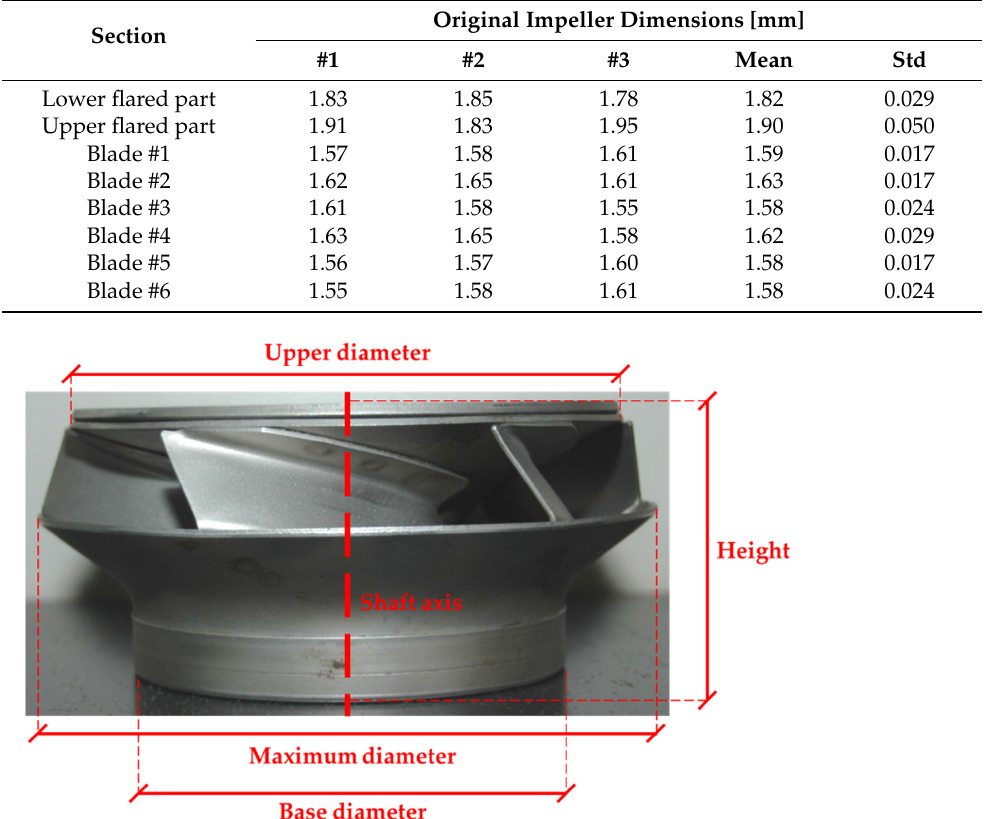
Table 2. Thickness values of the sections constituting the original impeller by Grundfos measured on three random points (indicated as #1, #2, and #3 for sake of simpleness). All of the values are expressed in mm. “Std” stands for standard deviation.